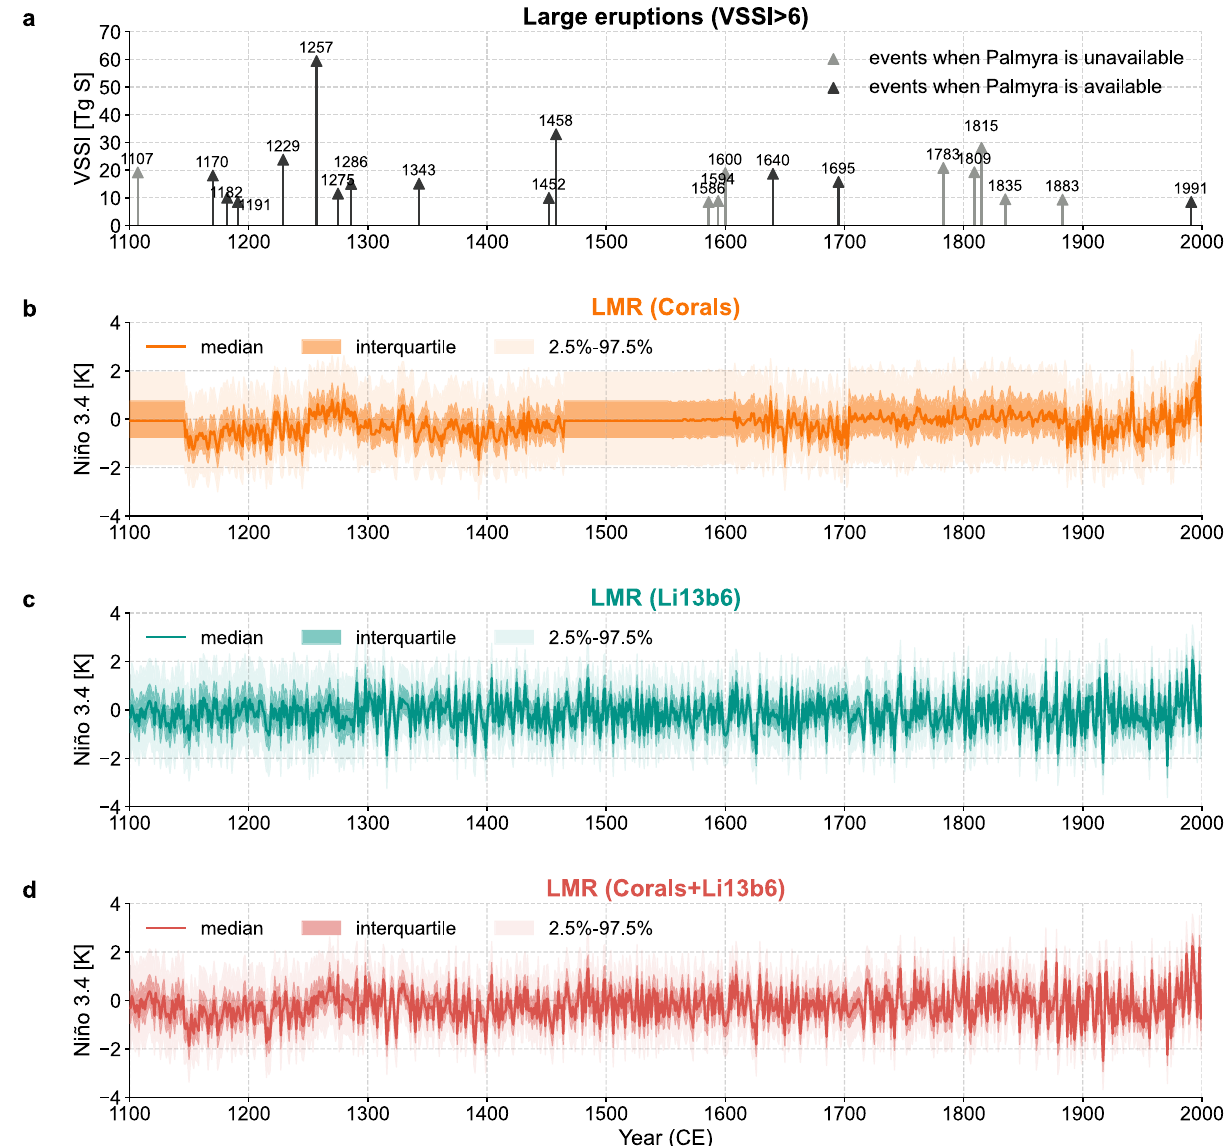
Fig. 2 Timing of eruptions and ENSO events over 1100 – 2000 CE. a The 22 largest eruption events, de fi ned as a volcanic stratospheric sulfur injection (VSSI) greater than 6 according to eVolv2k version 3 45 and Toohey et al. 46 . The 13 events sampled by the Palmyra coral record 27,28 are colored in black, while other events are colored in gray. b – d Niño 3.4 reconstructions over the 1100 – 2000 CE period estimated with the Last Millennium Reanalysis (LMR) framework 31,32 . For each reconstruction, dark shading denotes the interquartile range, while light shading denotes the central 95% region (2.5% to 97.5%